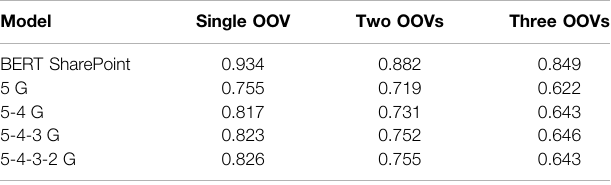
TABLE 4 | Comparison of intent classi fi cation accuracy using the best BERT model vs. conventional n-gram models.